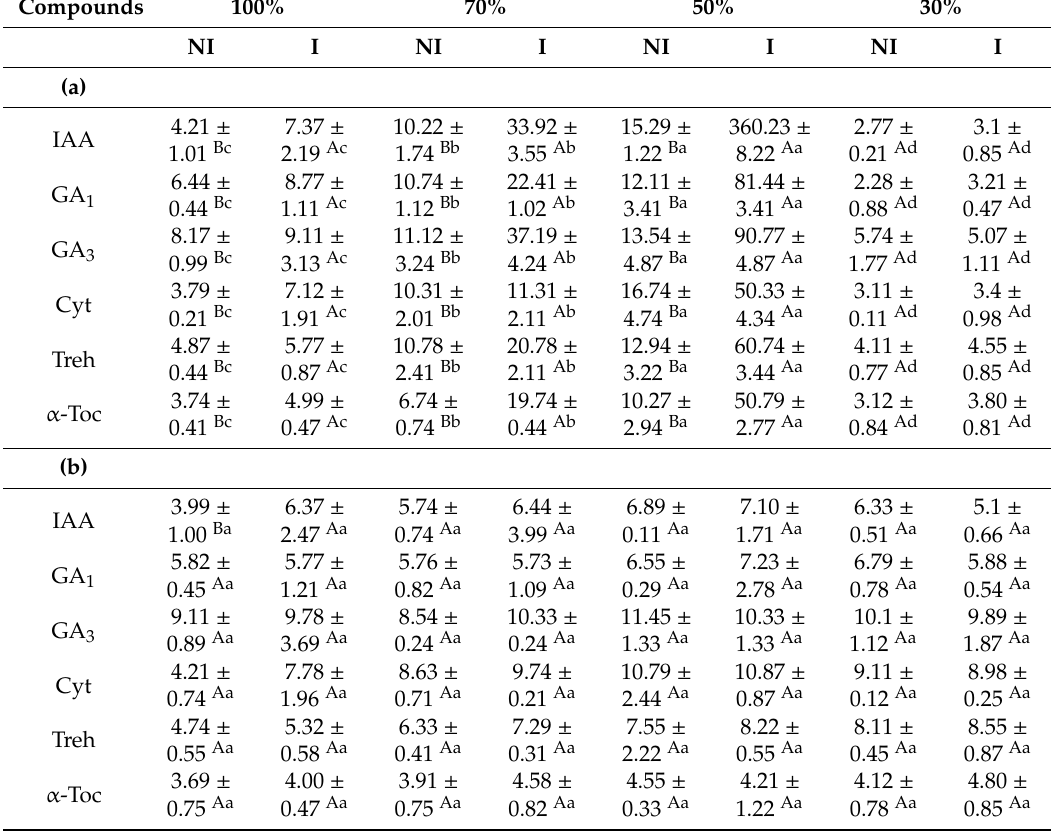
Table 1. Quantification of indole-3-acetic acid (IAA), gibberellic acid 1 (GA 1 ), gibberellic acid 3 (GA 3 ), Cyt (trans-zeatin), trehalose (Treh), and α -tocopherol ( α -toc) for the plants of red rice grown in the presence and absence of G. diazotrophicus strains Pal5, under ( a ) water restriction and ( b ) rehydrated conditions. The concentrations of di ff erent types of phytohormones were calculated in ng / mL, while trehalose and α -tocopherol were calculated in mg / L. Mean values and standard errors ( ± ) were calculated from the results of the three replicates. Averages followed by identical capital letters do not di ff er in the inoculation condition for each soil water treatment, and averages followed by identical lowercase letters do not di ff er in the percentage of soil water Compounds 100%